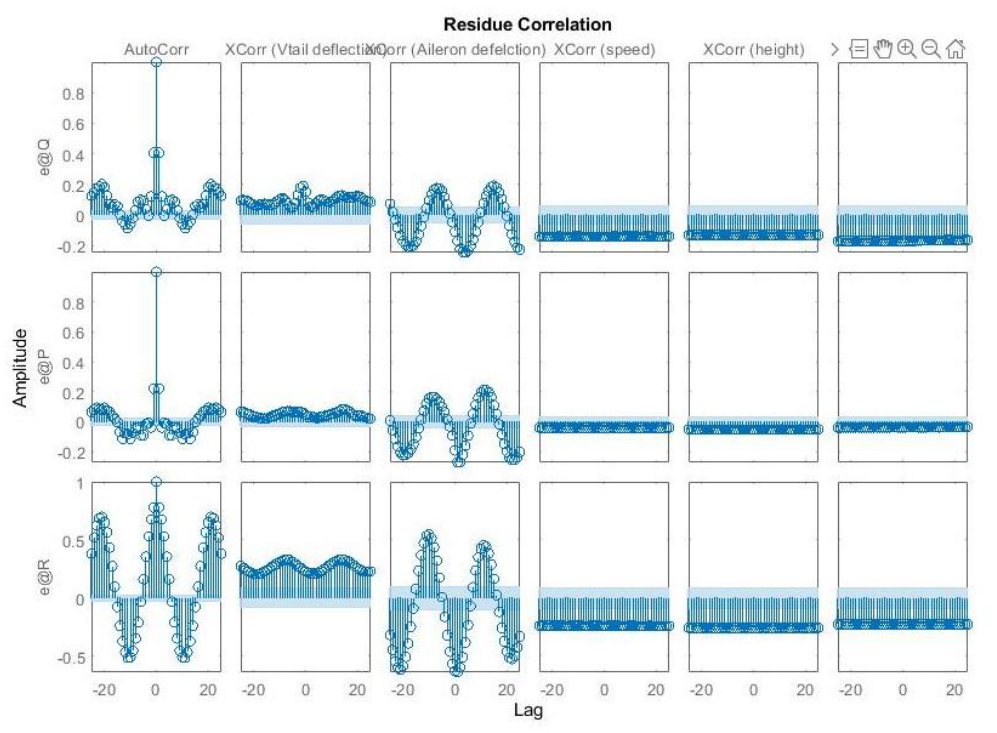
Figure 24. Residue